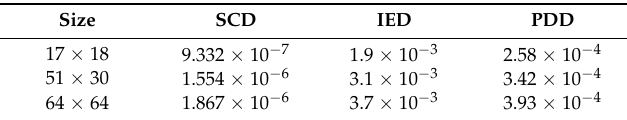
Table 3. Time cost of main stages in the discrimination (seconds).